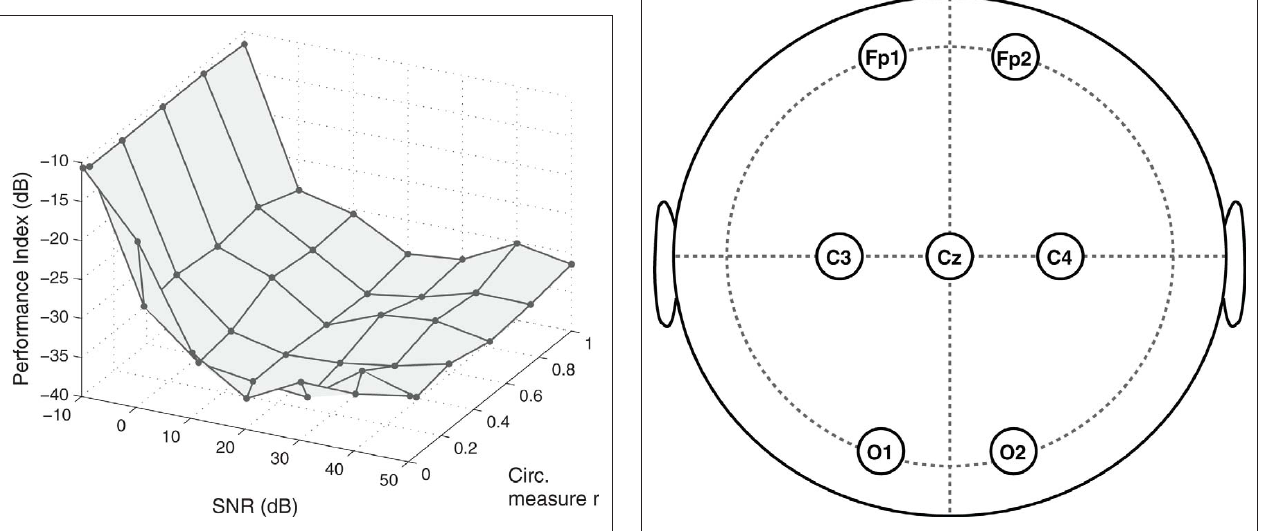
FiGurE 8 | Comparison of the performance of algorithm (22) with respect to changes in the SNr and the degree of noise circularity.